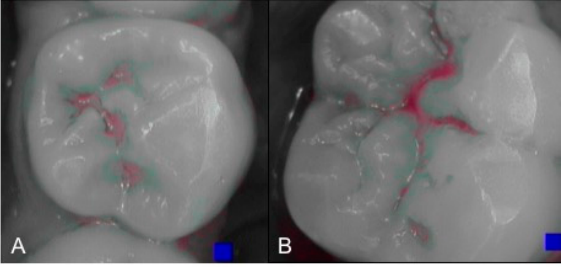
Figure 4. ( A , B ). Intraoral camera Soprocare images of active demineralization processes on the occlusal surface of the teeth.